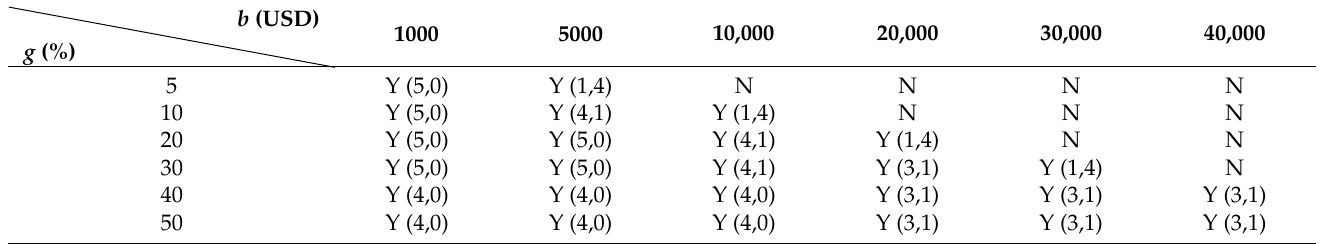
Table 4. Impact of the investment cost and fuel consumption saving rate on the operation decisions.